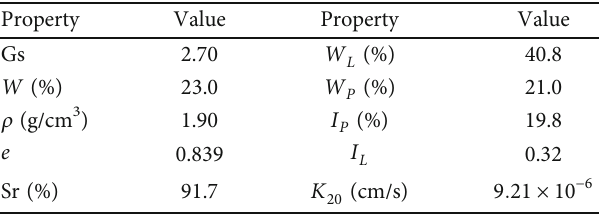
Table 1: Basic physical and mechanical properties of the soil samples.